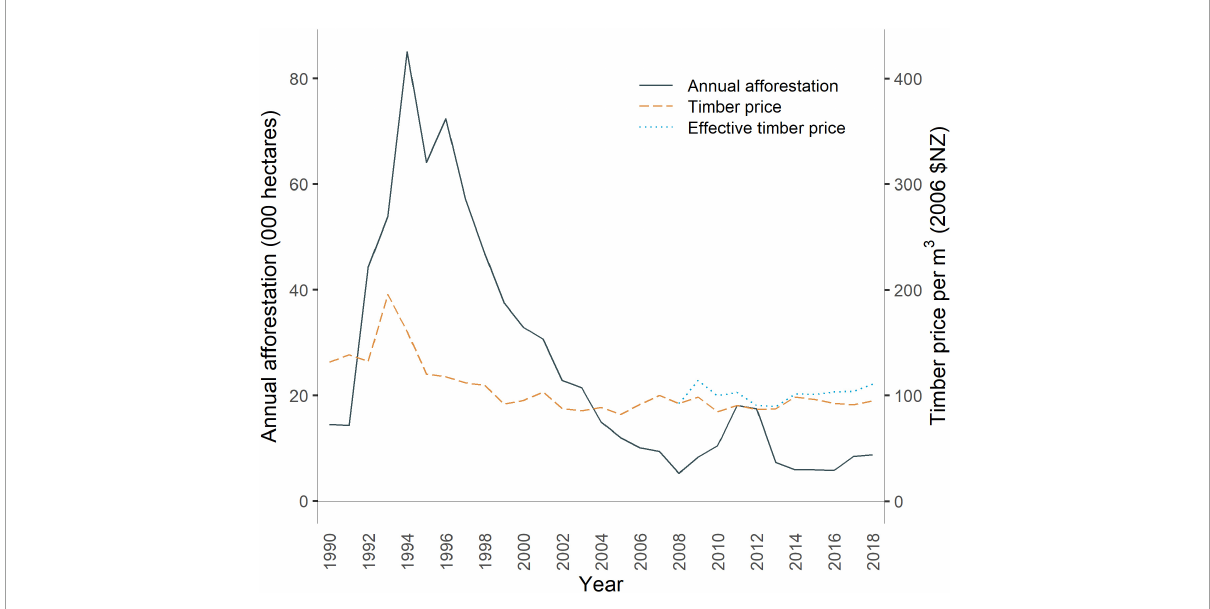
FIGURE9 Annual afforestation and timber prices (with and without accounting for the effect of the NZU price). Data from MPI (2019b), Jarden (2022), and MfE (2022a).